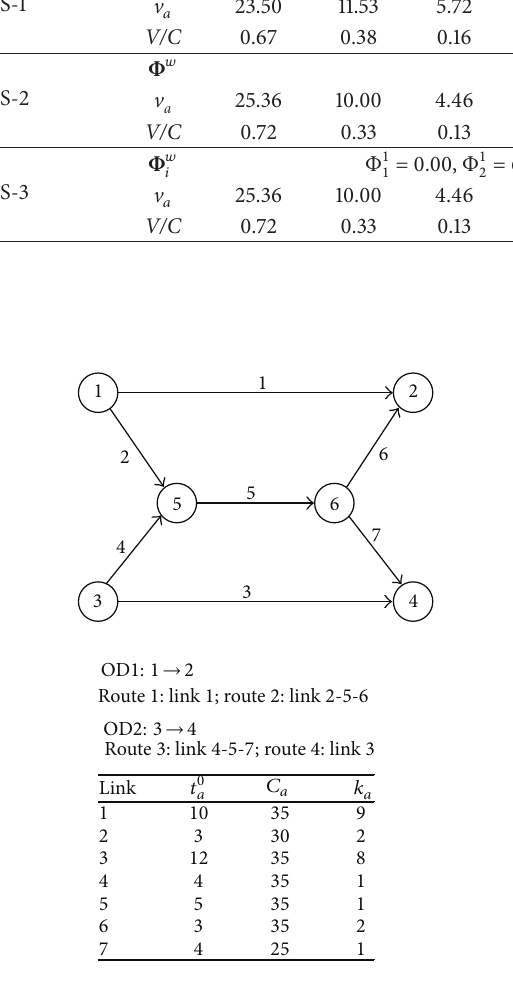
Figure 2: The six-node seven-link